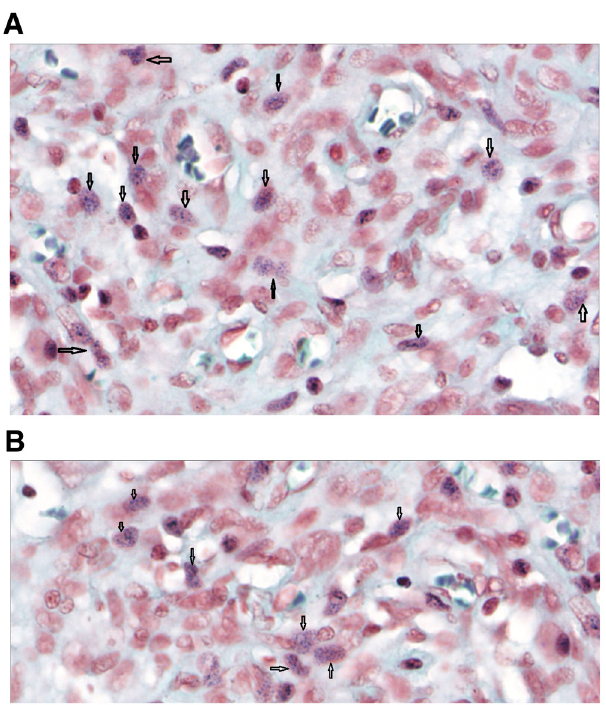
Figure 4. Human brain histochemistry. ( A and B ) Human brain Gram stain (magnification, ×80). Gram positive granules were also present in the brain. Black arrows indicate the intracellular blue granules.